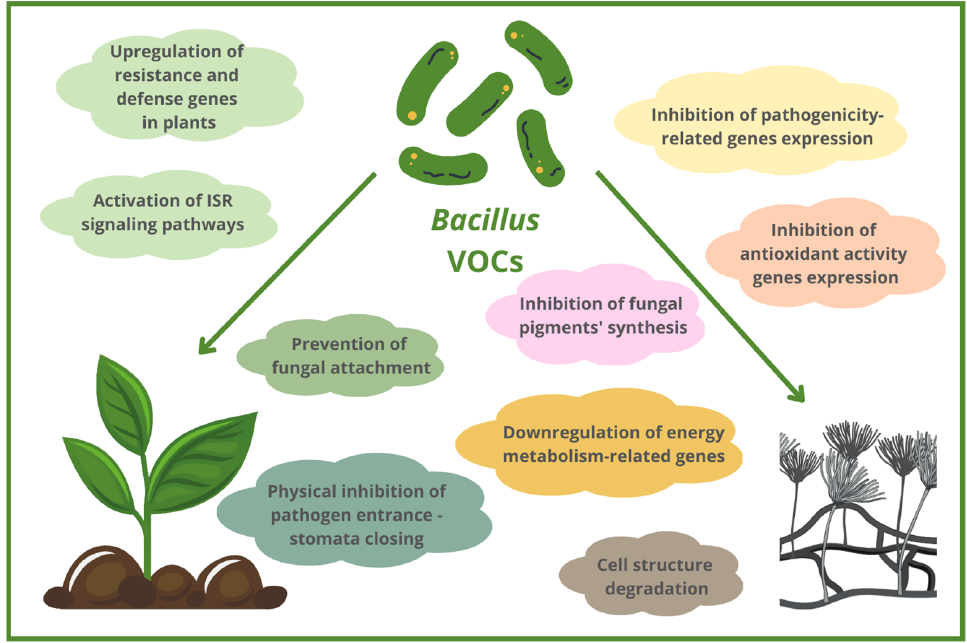
Figure 3. Antifungal mechanisms of action of Bacillus ‐ based VOCs (ISR—induced systemic resistance).